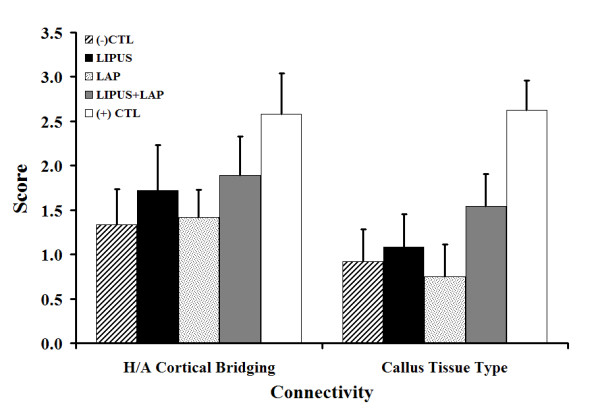
Decalcified connectivity scores. Results presented as Mean ± SEM where the mean was compiled by averaging scores from the proximal, middle and distal slides; connectivity scores were on average higher in the +CTL group relative to all other experimental treatments and the -CTL, which, at four months, elicited a minimal level of osseous bridging; LIPUS treatment appeared to improved osseous bridging and the degree of ossified tissue in the callus; a similar observation was made with the LAP treatment, though the degree of ossified tissue within the callus was smaller; combination treatment seemed to improve direct healing relative to all other treatment groups excluding the +CTL; LEGEND: H = host; A = allo/autograft. All statistical comparisons relative to the -CTL were not significant (p > 0.05).